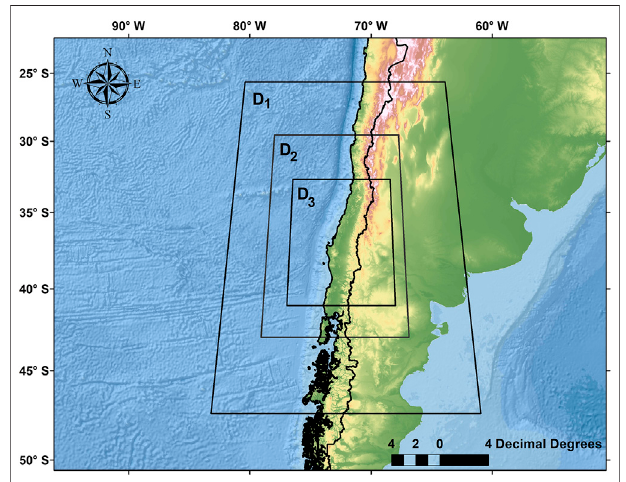
FIGURE 3 | Display of the domains used in weather research and forecasting model. D 1 : parent domain with 36-km resolution. D 2 : fi rst nesting with12-kmresolution(1/3parentdomainsize).D 3 :secondnesting,with4-km resolution (1/9 parent domain size).